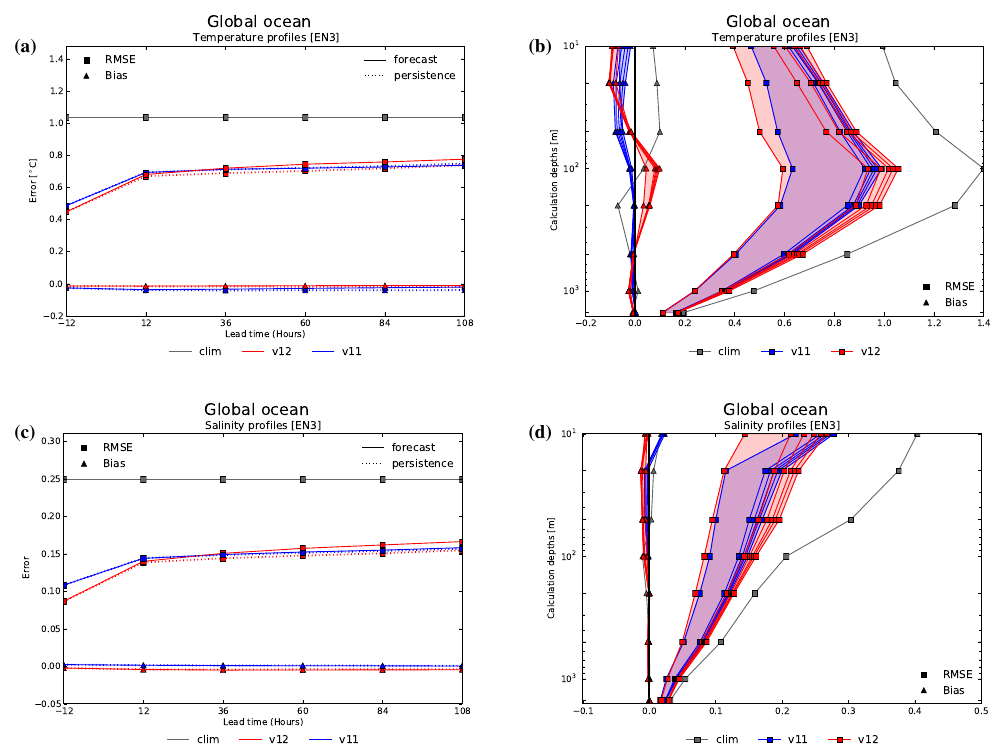
Figure 7. Global rms errors (squares) and mean errors (triangles) against sub-surface profiles of temperature (upper; ◦ C) and salinity (lower; measured on the practical salinity scale) from the EN3 data set averaged over all forecasts performed during the trials in waters deeper than 200m. Plots show results for the v12 (red) and v11 (blue) trials as well as the EN3 climatology (grey). The left-hand plots, (a) and (c) , show model forecast errors (solid lines) and persistence errors (dotted lines) against forecast lead time (in hours) ranging from the analysis fields at T − 12h up to the 5-day forecasts at T + 108h. The right-hand plots, (b) and (d) , show forecast profile errors against model depth (m) on a log scale for the analysis and each of the 5 forecast days ( T + 12h– T + 108h) to show the evolution of error profiles with forecast lead time. The area between the analysis ( T − 12h) and forecast day 5 ( T + 108h) is shaded red for v12 or blue for v11.